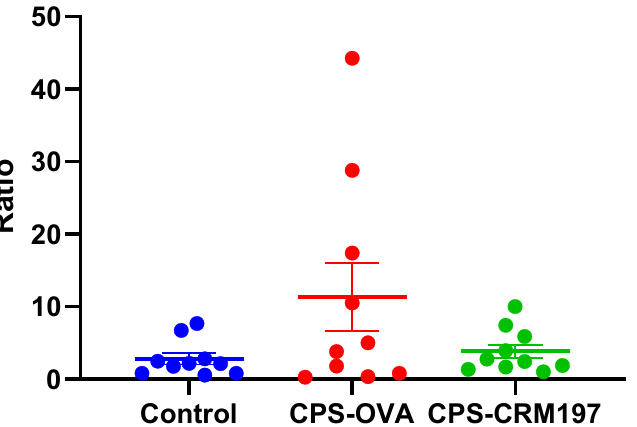
Figure 6. Cellular immune response to cCPS in vitro re-stimulation. Flow cytometry. Isolated PBMCs were re-stimulated in vitro with cCPS and subsequently stained for surface markers (CD3, CD4) and intracellular IFN γ . The ratio of IFN γ producing cells was analyzed from all CD3+CD4+ cells. The data are expressed as the ratio calculated: percentage of CD4+IFN γ + from the cCPS-stimulated sample/percentage of CD4+IFN γ + from the un-stimulated sample. Data are presented for individual animals from (not vaccinated) control, CPS-OVA- and CPS-CRM197-immunized pigs. The number of responders was not statistically different when both groups of conjugated-vaccinated animals were compared to controls ( p > 0.05, Fisher’s exact test).